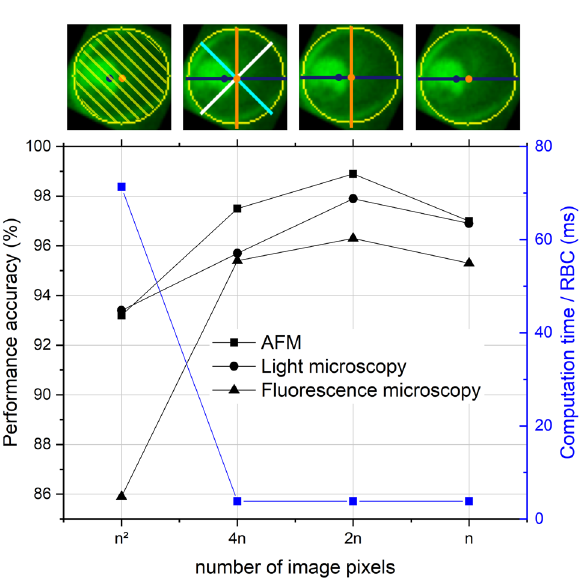
Figure 7. Classification performance of the convolutional NN and computation time per RBC versus the amount of input data for light microscopy, AFM, and fluorescence microscopy images. The NN was trained and 2 tested on 2D RBC images ( n pixels), four cross-sections (4 n ), two characteristic cross-sections (2 n ), and one single cross-section ( n ), the asymmetric cut. These four cases are illustrated by exemplary fluorescence images ◦ ◦ ◦ on the top. Asymmetric cuts are indicated with blue lines, while the 90 , + 45 and − 45 cuts are shown in orange, cyan and white,